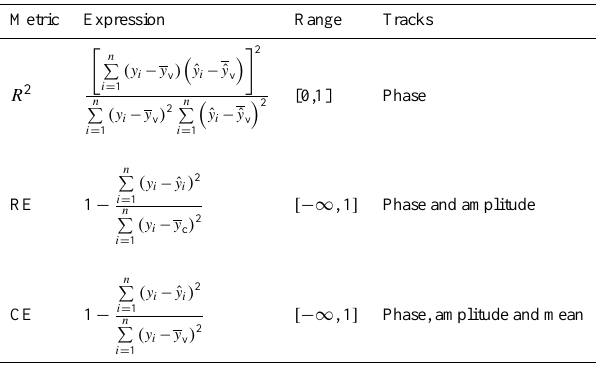
Table 1. Comparison between R 2 , RE, and CE. y i denotes the i th temperature grid point, and ˆ y i denotes the estimation of y i . y c and y v refer to the mean of ( y 1 , y 2 , ..., y n ) over the calibration pe- riod and verification period, respectively. Adapted from National Research Council (2006), Chap.